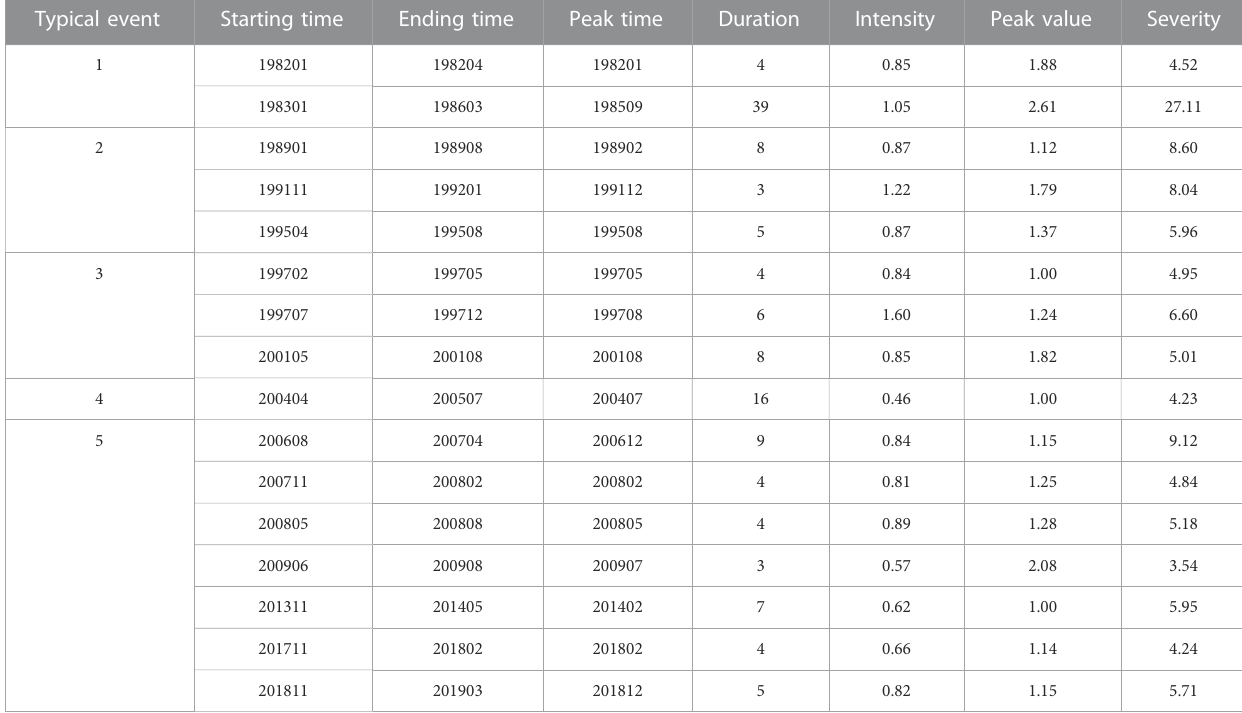
TABLE 3 Typical drought events and their basic characteristics in the Tianshan Mountains. Typical